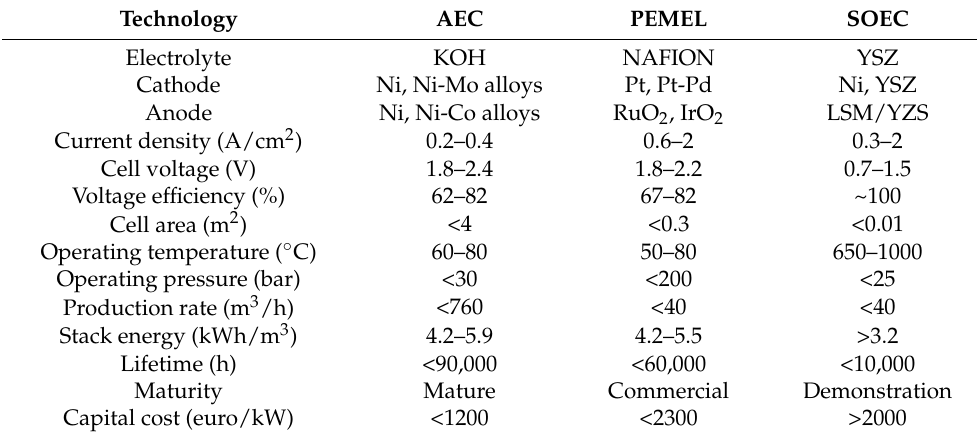
Table 1. Electrolysis cells